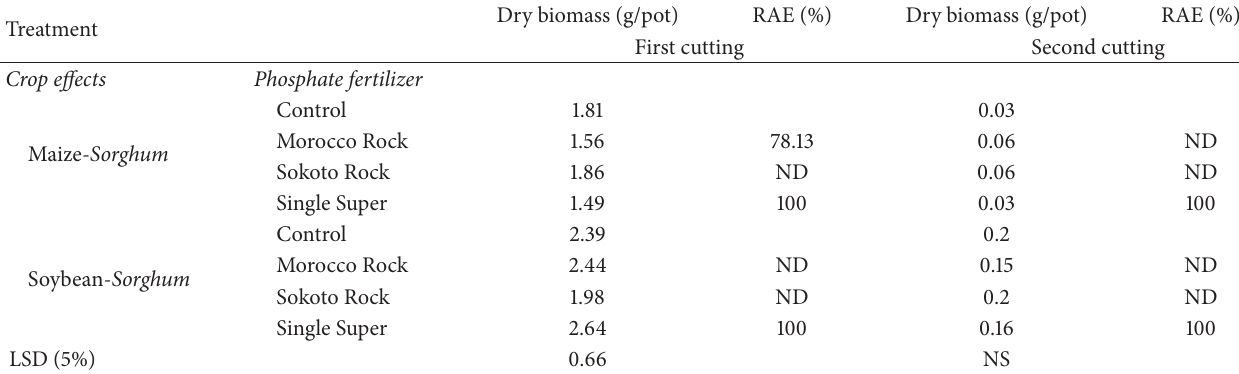
Table 8: Influence of crop effects and P-sources on biomass yield (g/pot) of Sorghum in the second cropping.